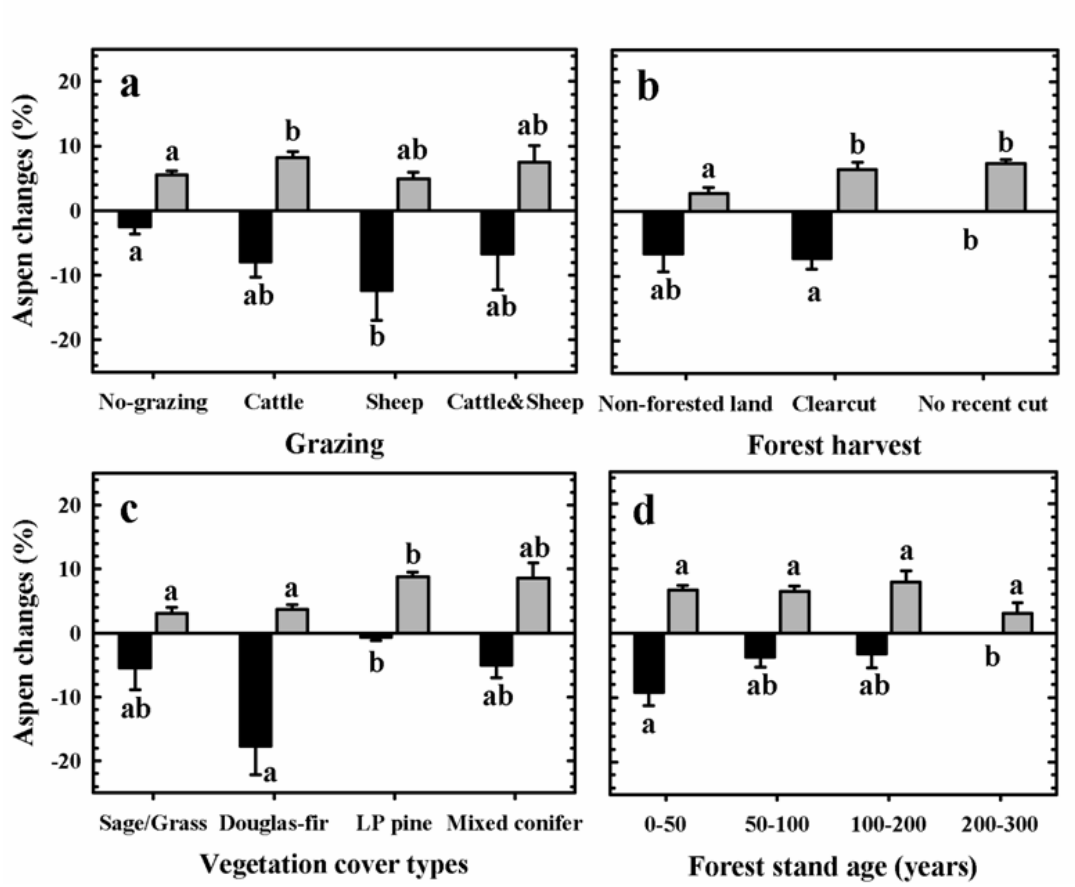
Figure 6. Aspen change patterns in the 1920–2005 time period. Aspen increase (positive grey bars) and aspen decrease (negative black bars) were simultaneously analyzed as two response variables in a MANOVA model. Grazing, forest harvest, and vegetation cover types were significant predictor variables in aspen increase (p < 0.05), while all predictor variables were significant in aspen decrease (p < 0.05). (a) Aspen changes patterns and grazing; (b) Aspen change patterns and forest harvest; (c) Aspen change patterns and vegetation cover type (LP pine = Lodgepole pine); (d) Aspen change patterns and forest stand age.